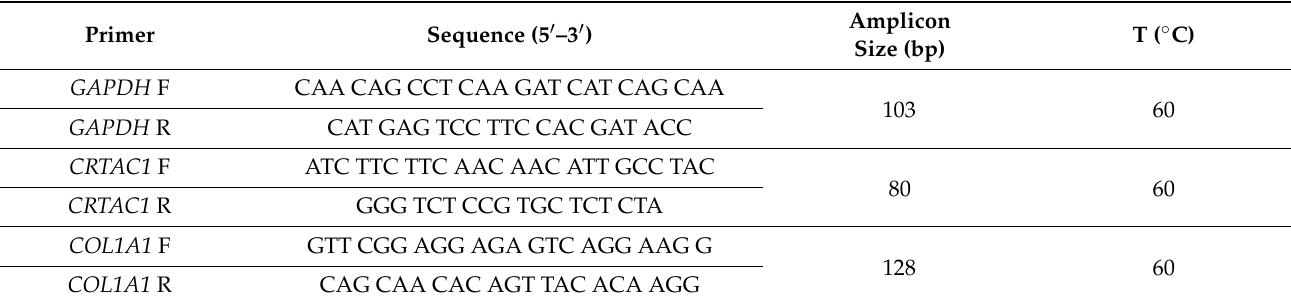
Table 1. Primer pairs used in this